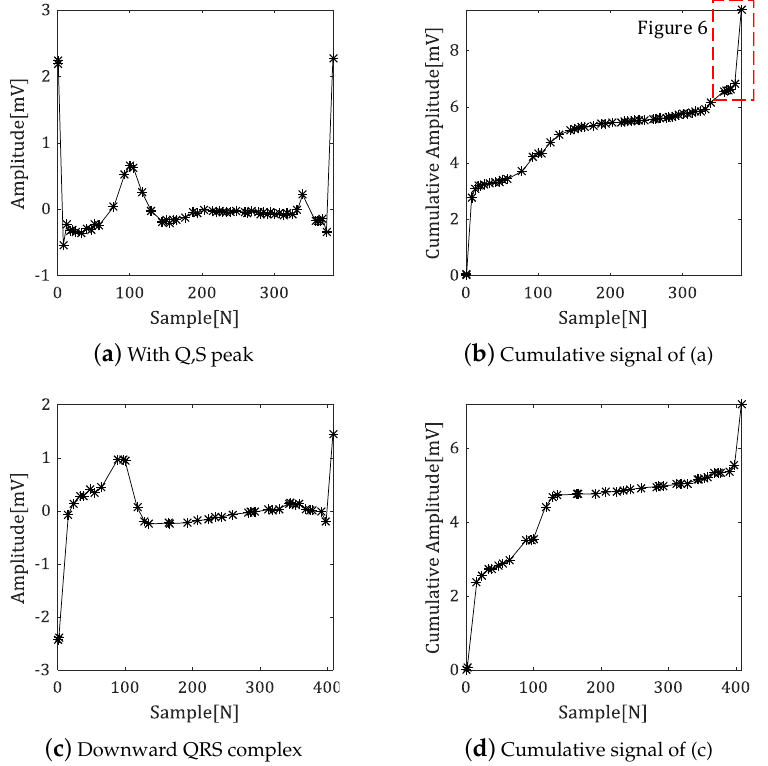
Figure 5. Comparison of cumulative signal results according to waveform